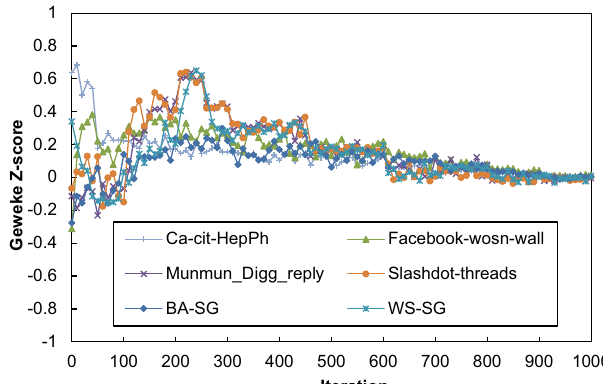
Figure 6. The plot of the Geweke Z-score versus iteration number for LA-IP on the stochastic test